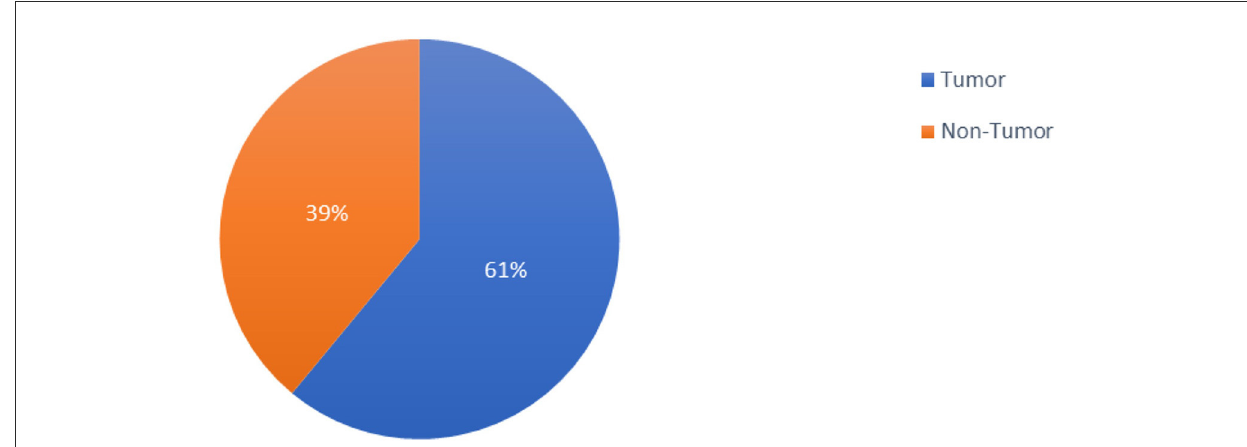
FIGURE2 Pie chart showing the distribution of tumorous and non-tumorous images in the dataset.